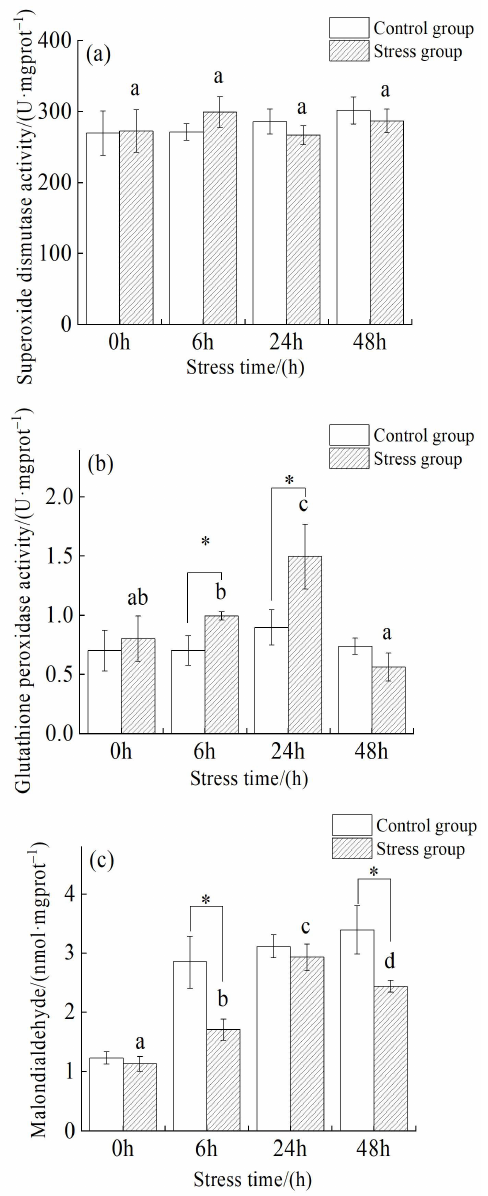
Figure 3. Effect of acute low salt stress on the antioxidation of liver of juvenile yellowfin fish ( Thunnus albacares) , ( n = 9). ( a ), Superoxide dismutase activity; ( b ), Glutathione peroxidase activity; ( c ), Malondialdehyde. Different letters indicate the difference between the experimental group and the control group over time, and * indicates the difference between the experimental group and the control group.